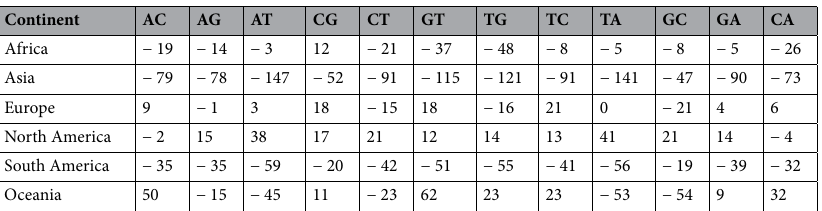
Table 4. Observed mutant variants between male and female